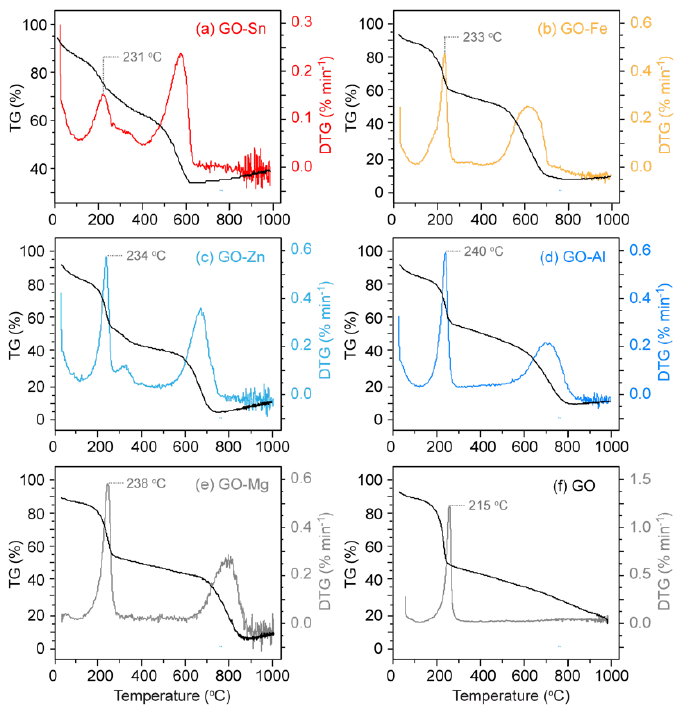
Table 2. Fraction of reduced carbon (%) calculated by NMR and weight loss (%) calculated by